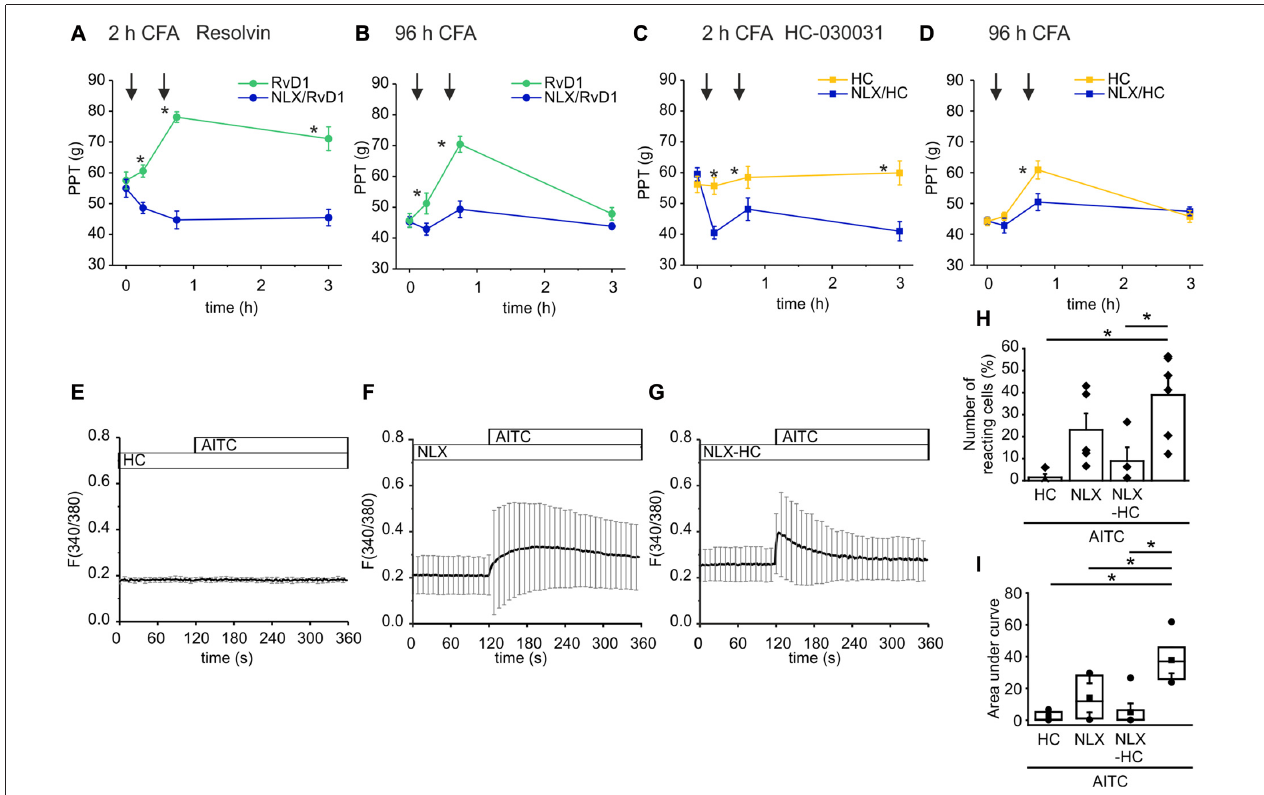
FIGURE 6 | Naloxone reverses antagonism of RvD1 and HC-030031 in vivo and impairs TRPA1 blockade in vitro . (A–D) Measurements of PPTs (g) in the early (A,C) and the late phase (B,D) of CFA-induced inflammation. First naloxone was injected (1st arrow, blue lines) or saline (yellow/green lines). Subsequently, naloxone plus RvD1 (A,B) or HC-030031 (C,D) were injected in the corresponding naloxone group (blue lines; 2nd arrow) while only the TRPA1 antagonists RvD1 ( A,B ; green) or HC-030031 ( C,D ; yellow) were applied in the control groups. Mechanical nociceptive thresholds were obtained at indicated time points. ( n = 5 per group, mean ± SEM; two-way ANOVA RM post hoc Holm-Sidak, ∗ p < 0.05 naloxone + RvD1/HC-030031 vs. solvent + RvD1/HC-030031). (E–G) Representative measurements of calcium transients in DRG neurons pre-incubated for 5 min in HC-030031 (10 µ M), naloxone (10 µ M) or HC-030031 plus naloxone before stimulation with AITC (10 µ M) at indicated time points. Mean ± S.D. (H,I) Statistical analysis of the number of reacting cells (%; H ) area under curve (taken from 160 s to 340 s; I ). AITC: n = 6; pretreatment with HC-030031 n = 4; pretreatment with naloxone: n = 5; pretreatment with HC-030031 plus naloxone: n = 7; mean ± SEM, One-way ANOVA post hoc Holm-Sidak, p <